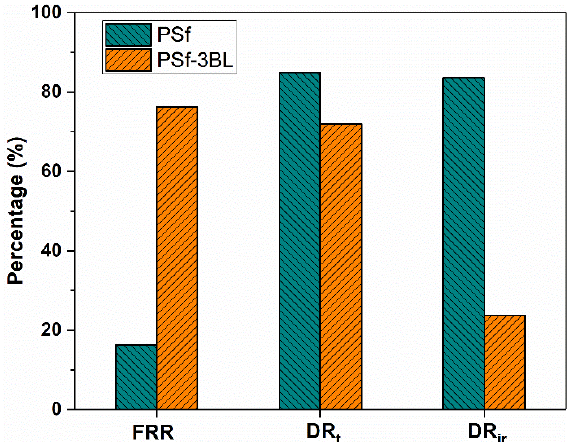
Figure 10. A summary of the corresponding FRR , DR t , and DR ir values of PSf and PSf-3BL membranes during the dynamic BSA filtration under neutral pH.